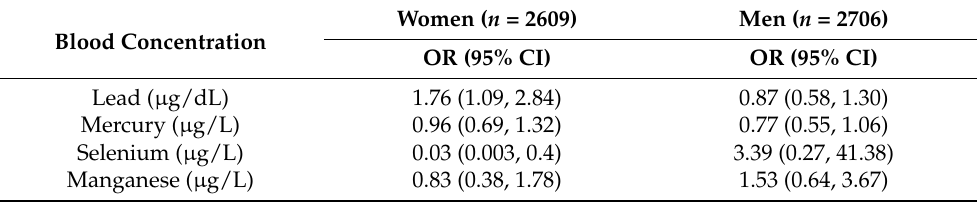
Table 5. Odds of low grip strength for a 10-fold increase in blood concentration of elements.